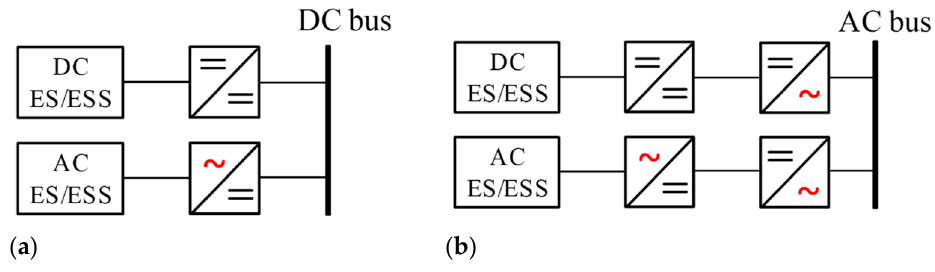
Figure 5. Practical power conversion system, ( a ) DC bus based, ( b ) AC bus based.